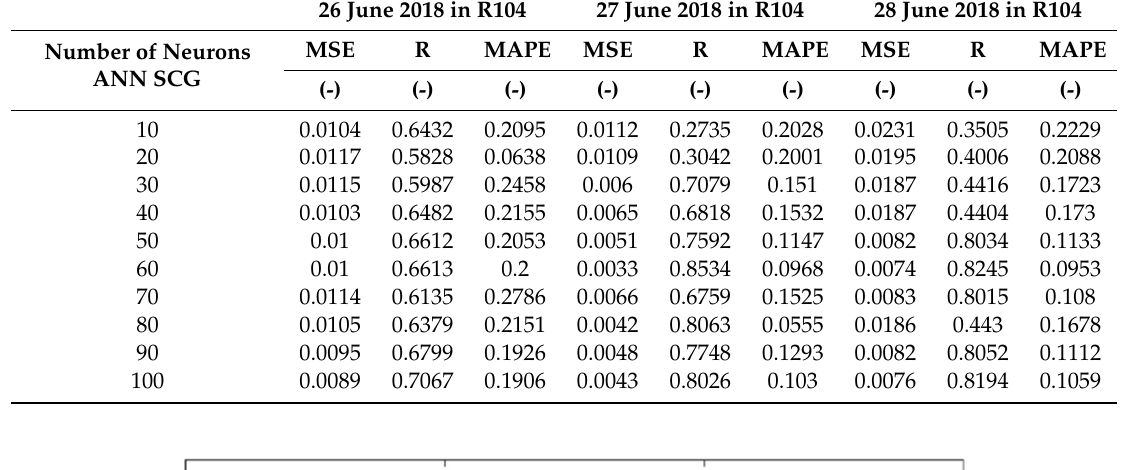
Table 7. Learned ANN SCG from 25 June 2018 in R203 (with T in, rH in and an FBG sensor for PPM) and prediction with cross-validation for 26 June 2018 in R104 (with T in, rH in and an FBG sensor for PPM), 27 June 2018 in R104 (with T in, rH in and an FBG sensor for PPM), 28 June 2018 in R104 (with T in, rH in and an FBG sensor for PPM).